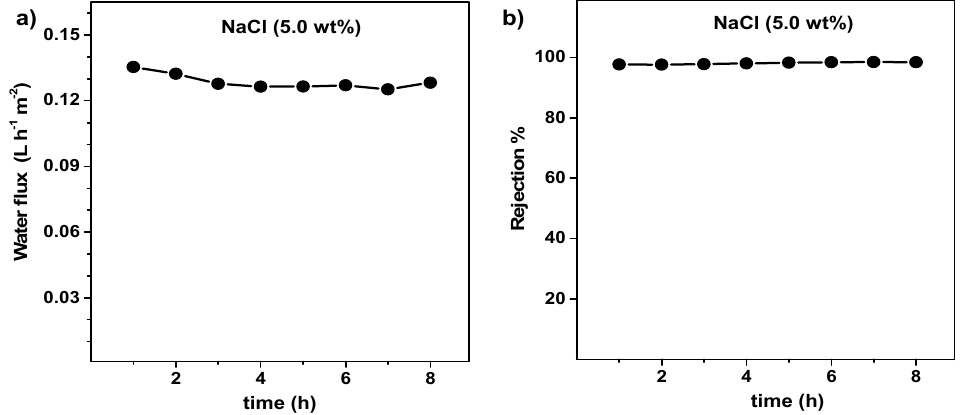
Figure 8. ( a ) permeate flux and ( b ) rejection (%) of the SiC-fob membrane while filtering 50 g L − 1 NaCl in deionized water over 8 h, rejection was calculated by Equation (1) (feed inlet = 73 °C, feed outlet = 59 °C, permeate inlet = 11 °C, permeate outlet = 31 °C).